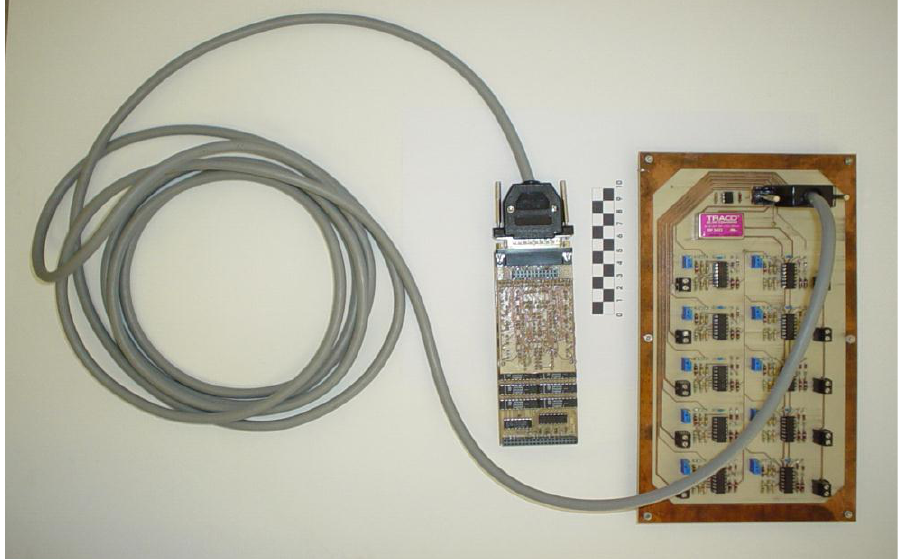
Figure 5. Electronic circuit for time delays measurements.